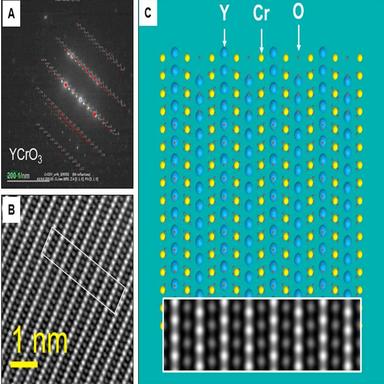
(A) - SAED image obtained for the area marked "1" in; (B) - STEM-HAADF image recorded at an atomic resolution for the area in which the precipitate had been found; (C) - Computer-simulated perovskite structure in the ZA: orientation, with part of the STEM-HAADF image indicated by the white rectangle in superimposed in the lower part.